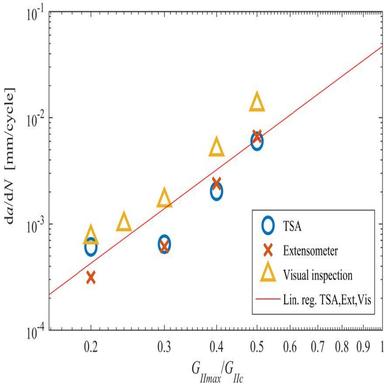
Paris law evaluation of the fatigue loading behavior under load control.